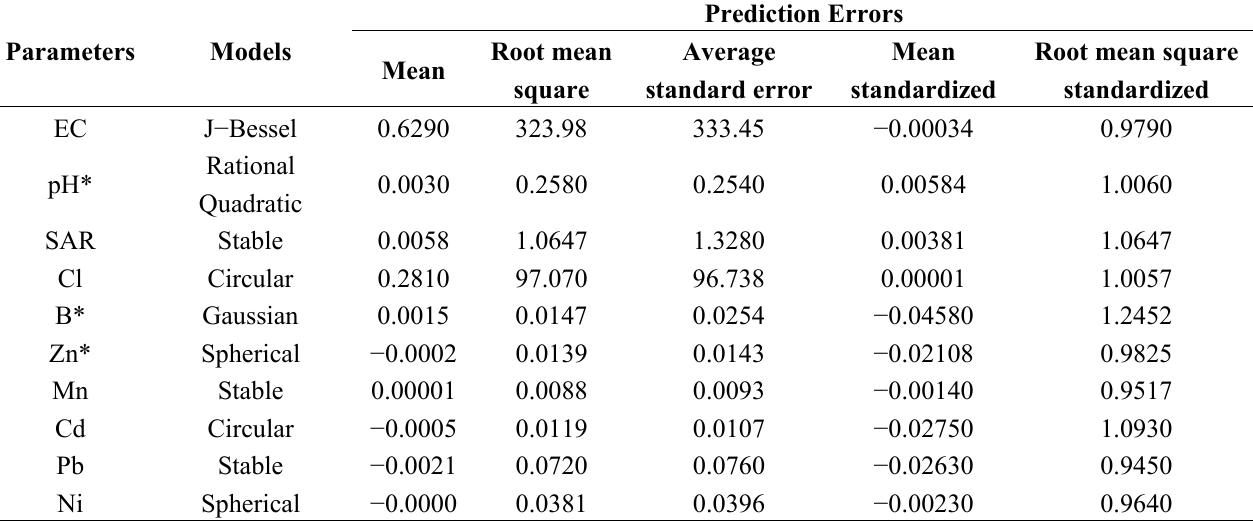
Table 9. Fitted parameters of the variogram model for groundwater